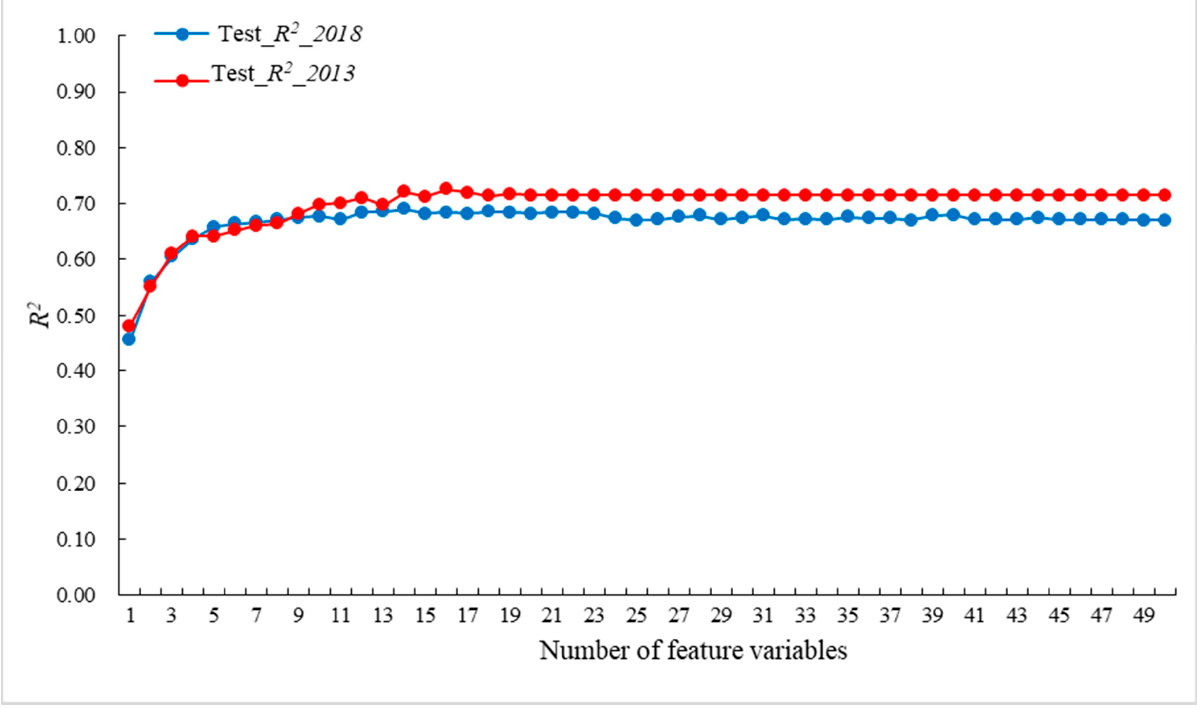
Figure 4. The relationship between the test R 2 and the number of feature variables in 2018 and 2013.